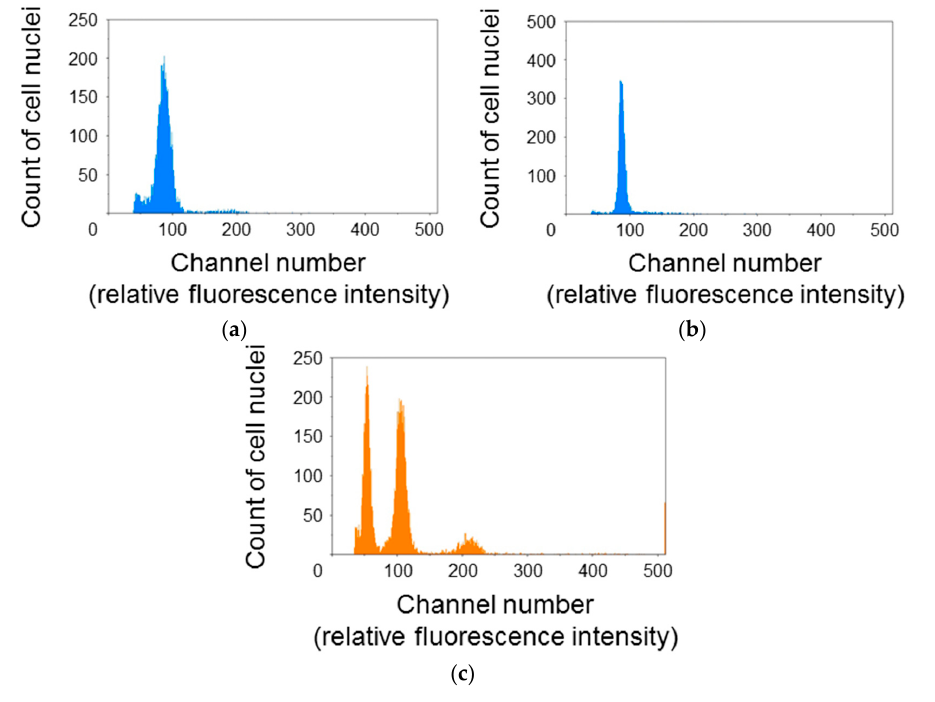
Figure 1. Cell cycle phase distribution of Physcomitrella patens protoplasts. Cell nuclei extracted from P. patens protoplasts immediately after isolation ( a ); P. patens protoplasts incubated for 24 h ( b ); and Arabidopsis